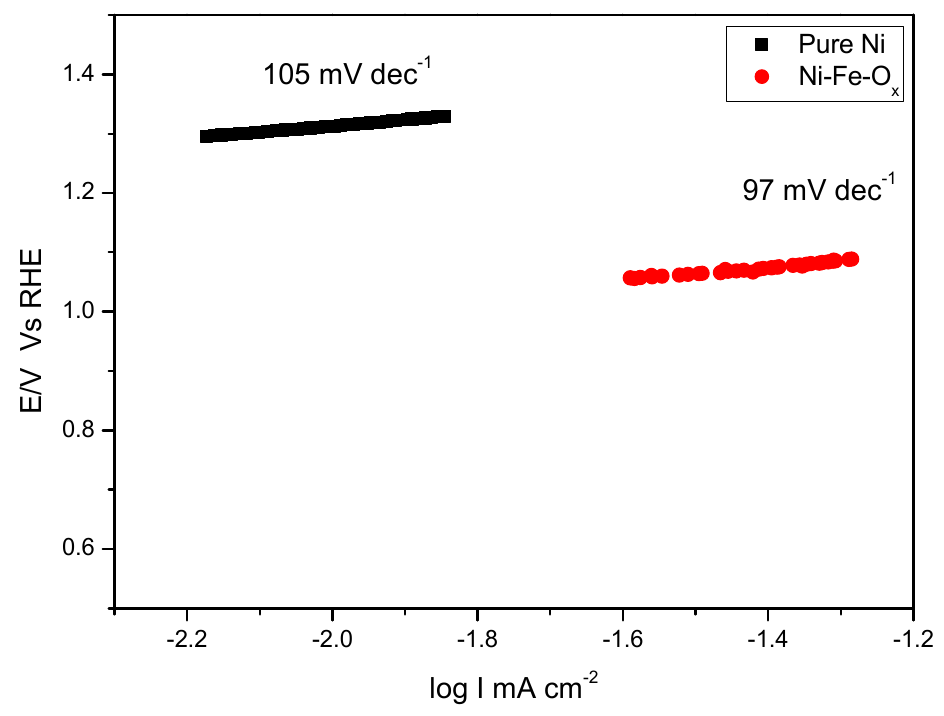
Figure 3. Tafel plots for the Ni–Fe–O x and pure Ni catalysts in 1 M KOH.